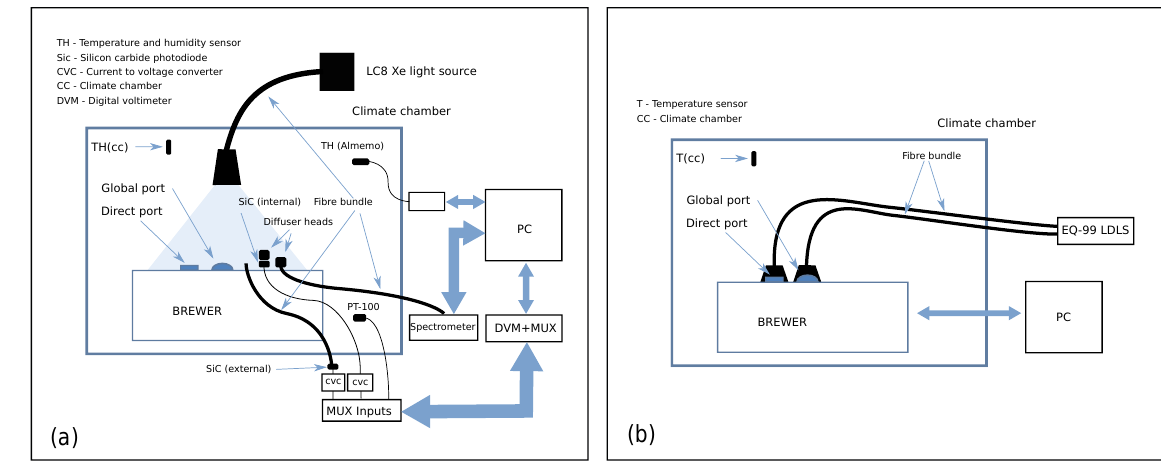
Figure 5. Measurement setups for used for the Brewer characterizations at PTB (a) and at Kipp & Zonen (b) .